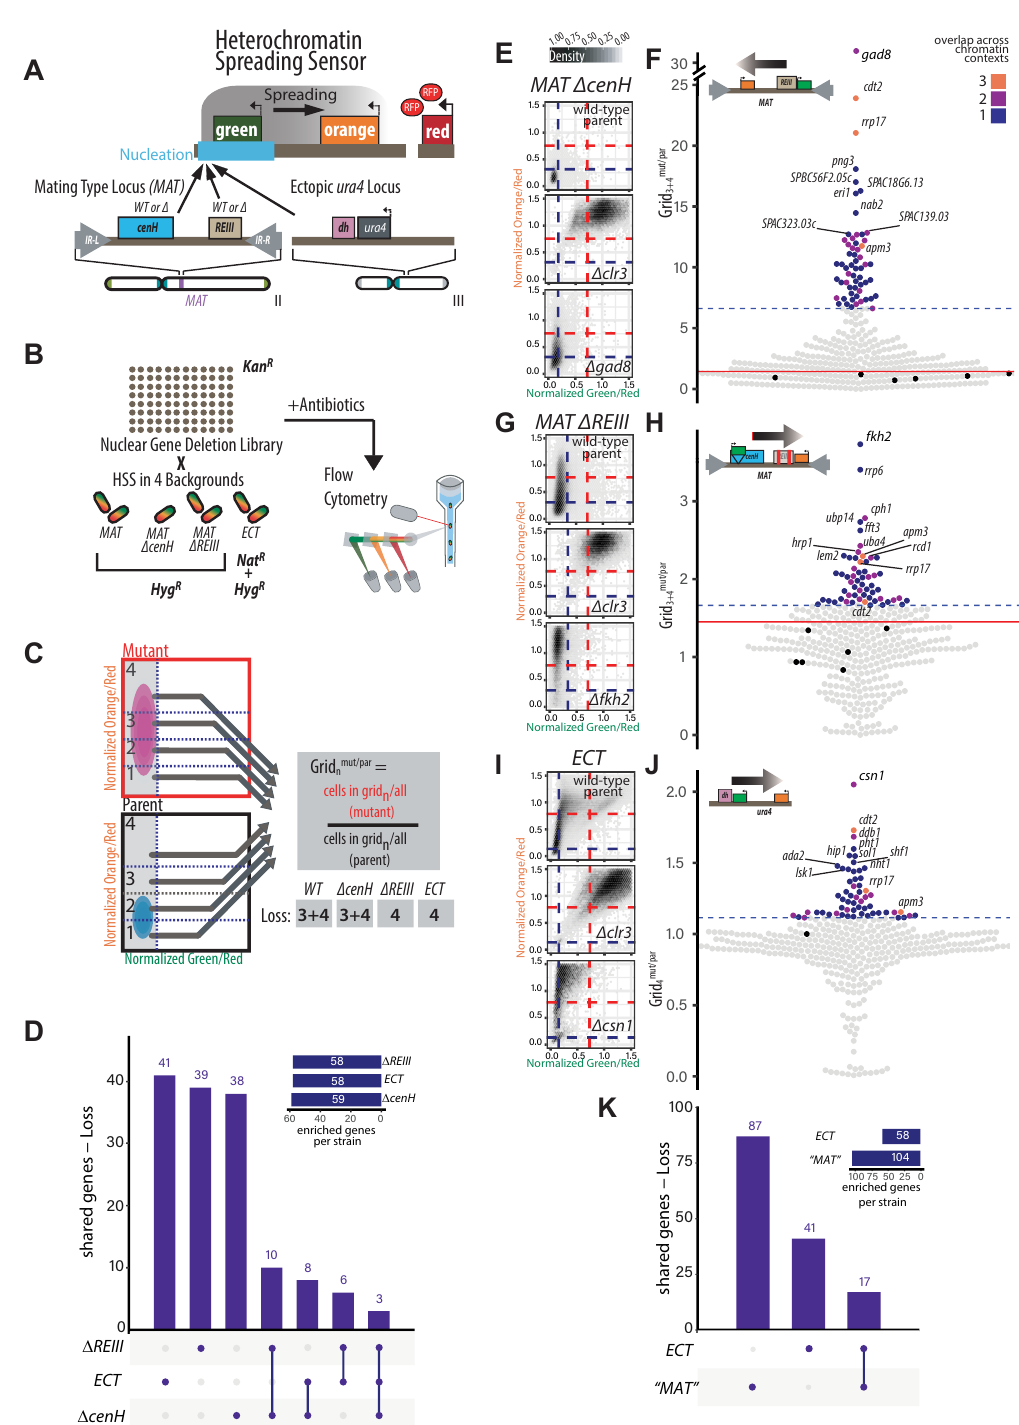
Fig 1. A genetic screen based on a suite of fluorescent reporters identifies regulators of heterochromatin nucleation-distal gene silencing in different chromatin contexts. A. TOP: Overview of heterochromatin spreading sensor (HSS, [24]). Three transcriptionally encoded fluorescent protein genes are integrated into the genome. SFGFP (“green”) proximal or internal to the nucleation site allows identification of heterochromatin nucleation; mKO2 (“orange”) distal to the nucleation site allows identification of heterochromatin spreading. 3xE2C (“red”) in a euchromatin region normalizes cell-to-cell noise. BOTTOM: The endogenous mating type locus ( MAT ) and heterochromatin ectopically targeted to the ura4 locus [24] were examined